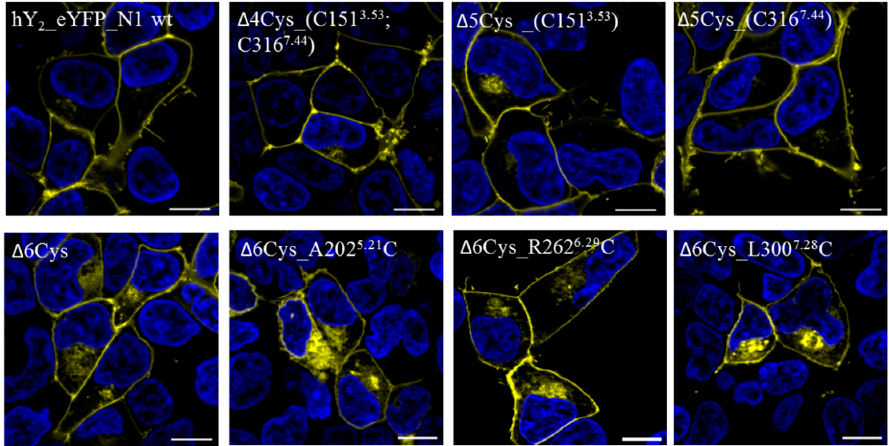
Figure 2. Cellular localization of Y 2 R cysteine variants: The live cell fluorescence images illustrate the cellular expression of eYFP-coupled Y 2 R cysteine mutants compared to the wild type (wt) Y 2 R (hY 2 _eYFP_N1 wt). For this purpose, the HEK293 cells were transiently transfected with the corresponding receptor constructs. The cysteine deficient variant ( ∆ 6Cys) exhibits a slightly higher intracellular localization compared to the wt receptor, but is still mainly expressed at the cell membrane. Similar expression patterns were observed for the cysteine mutants ∆ 6Cys_A202 5.21 C, ∆ 6Cys_R262 6.29 C and ∆ 6Cys_L300 7.28 C. The cysteine mutants ∆ 4Cys_ (C151 3.53 ; C316 7.44 ), ∆ 5Cys_C151 3.53 and ∆ 5Cys_C316 7.44 are almost completely localized on the cell membrane like the wtY = 2 R. Yellow eYFP, blue = nuclear dye Hoechst 33342. The scale bar corresponds to 10 µ m. n ≥